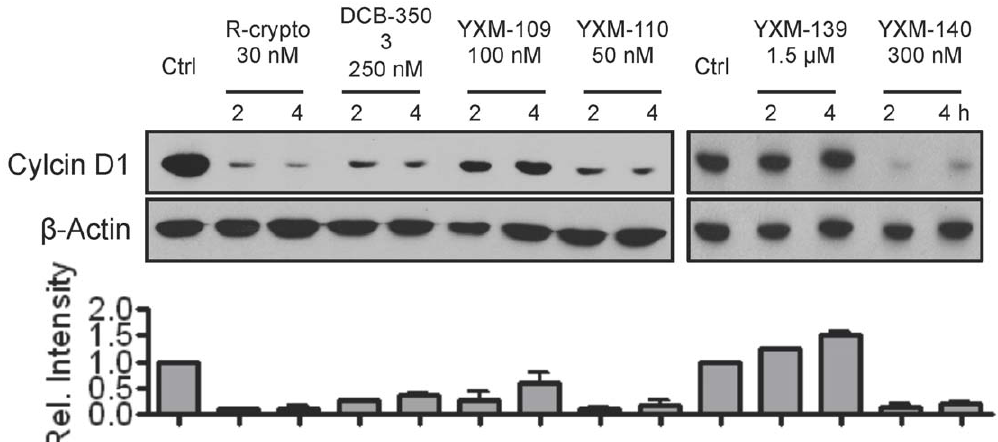
Figure 3. Functional crytopleurine analogs inhibited cyclin D1 expression. HepG2 cells were treated with crytopleurine analogs and DCB- 3503 with the dosage as indicated in the figure for 2 and 4 hours. Cyclin D1 protein level was analyzed by Western blot. The band intensity of Cyclin D1 on Western blot was normalized with that of b -actin by densitometer scanning, and presented as a chart below. Results were mean 6 SD from three independent experiments.